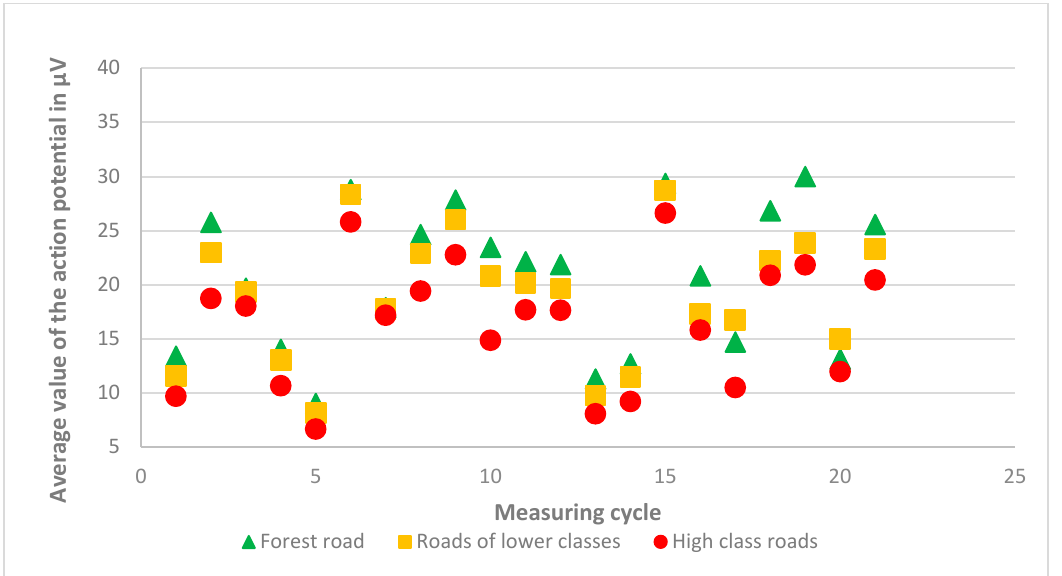
Figure 3. Comparison of the course of changes in muscle load expressed in μ V of electric potential on monitored types of roads when driving a timber truck (author).